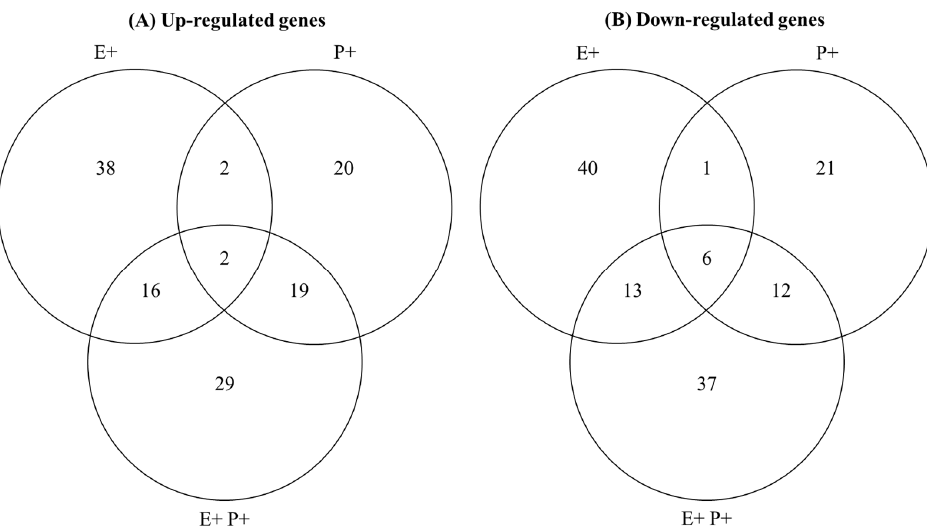
Figure 4. Number of up-regulated (panel A ) and down-regulated (panel B ) plant genes associated with defence responses given the presence of the endophyte Epichloë gansuensis (E+), the pathogen Blumeria graminis (P+) and both microorganisms (E+P+) on Achnatherum inebrians plants. The gene expression levels were measured at four weeks after the pathogen inoculation of plants ( n = 3). The entire list of genes is presented in Table S1.